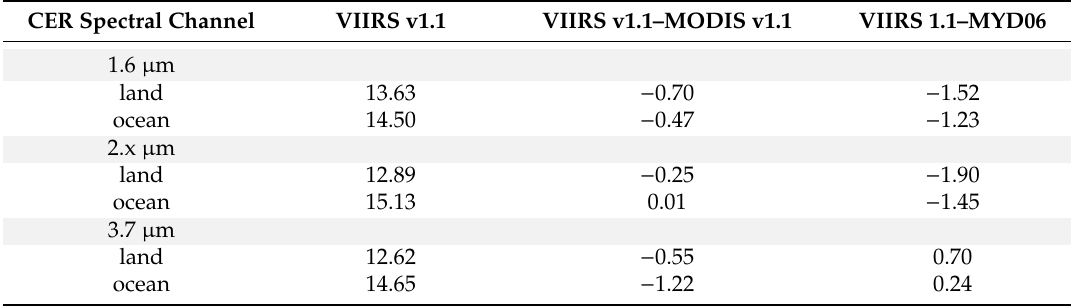
Figure 8. Same as Figure 7 but for the Kou et al. and Wagner et al. index of refraction datasets used in the publicly released version 1.1. VIIRS and MODIS continuity property algorithm. Note the smaller middle panel di ff erences for the SWIR retrievals. Table 3. Area-weighted ± 60 ◦ latitude mean CER and di ff erences in means for the panels of Figure 8, separated by land and ocean